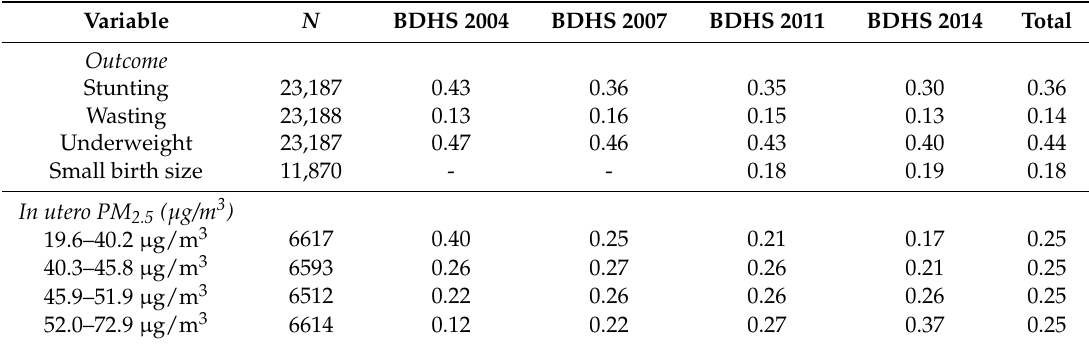
Table 1. Summary statistics for prevalence of outcomes and distribution of exposure by the Bangladesh Demographic and Health Survey (BDHS)